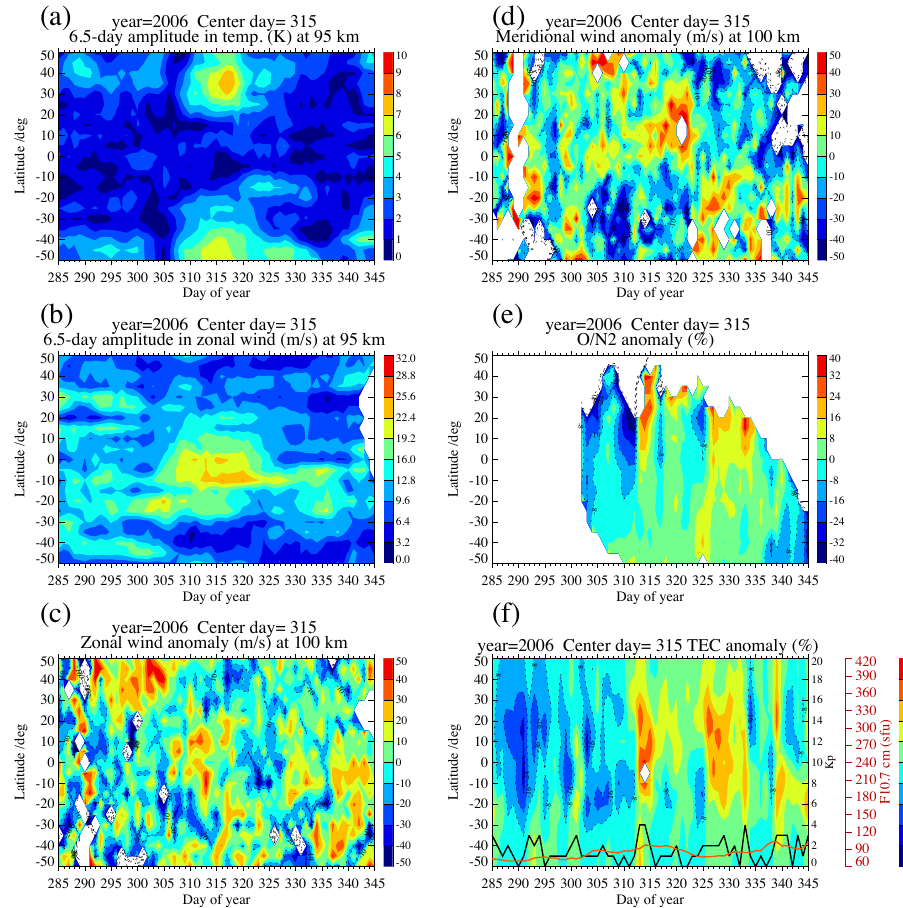
Figure 4. Same as Fig. 3, but for the duration of day 285 to 345 in 2006.